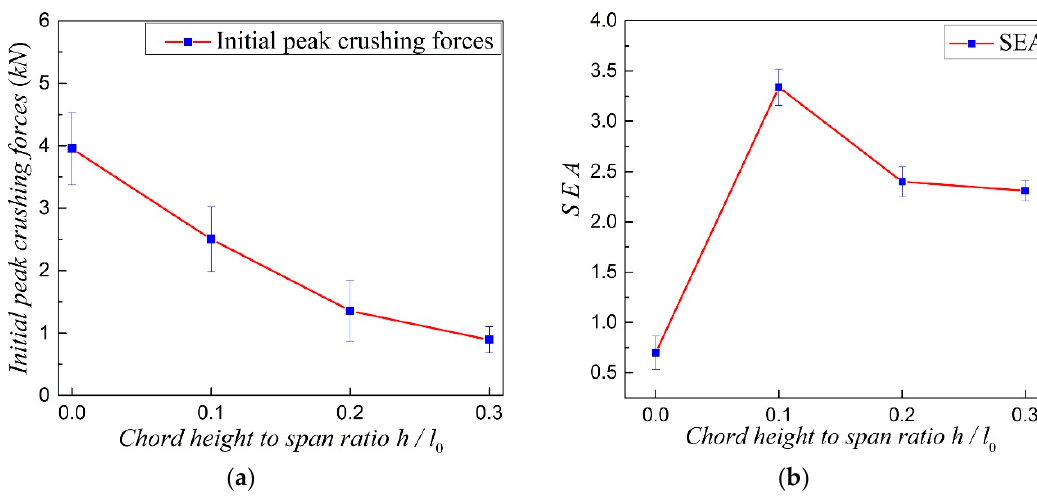
Figure 6. ( a ) Initial peak crushing forces and ( b ) specific energy absorption (SEA) of the three-dimensional (3D)-printed four samples COF0, CCF1, CCF2, and CCF3.